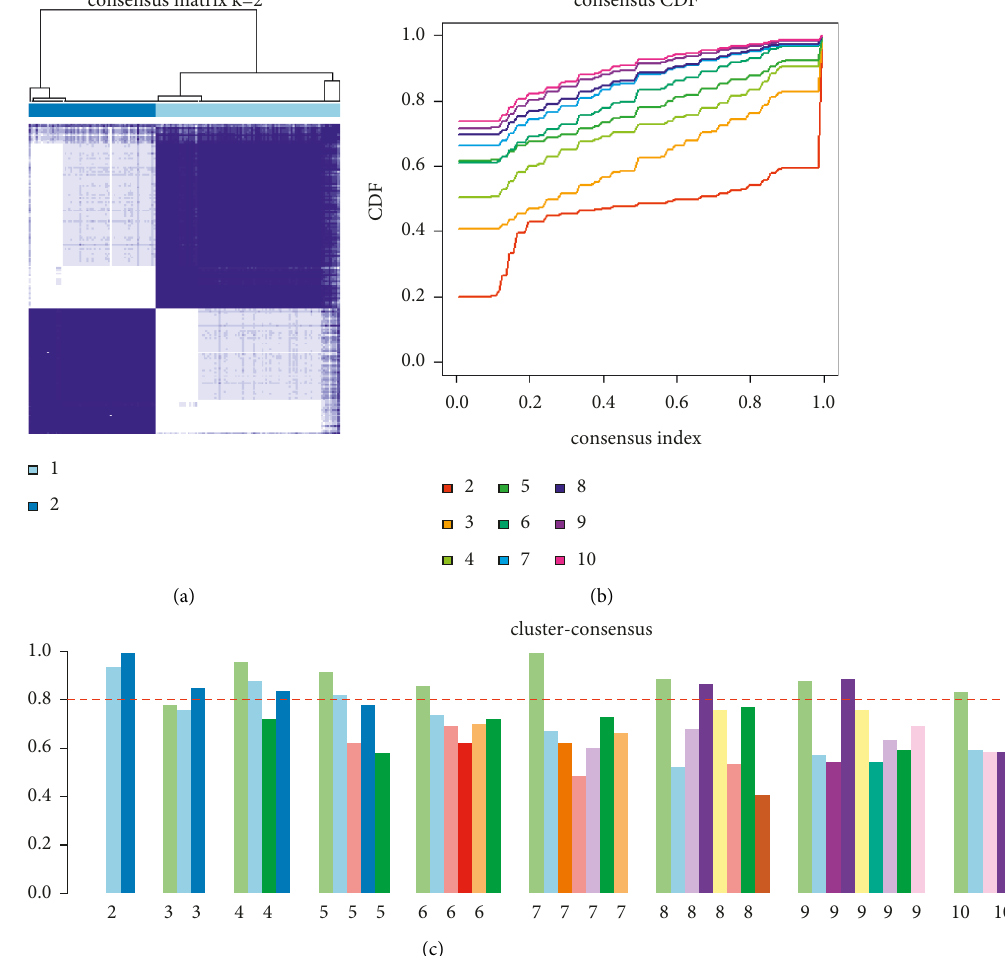
Figure 2: Consensus-based cluster analysis of gene expression in idiopathic pulmonary fibrosis. (a) The consensus matrix using a two-group model ( k � 2). (b) The plot of the cumulative distribution function (CDF) for each number of clusters tested. (c) The consensus scores analysis of each cluster.